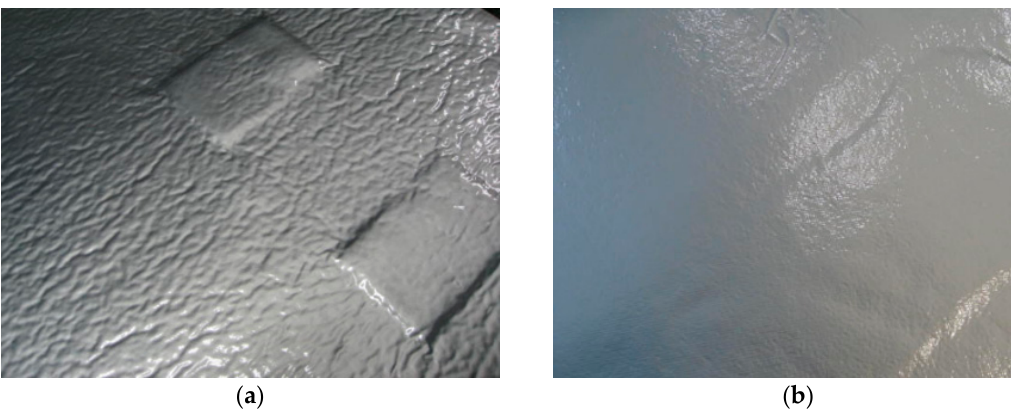
Figure 8. Comparison of formability improvement: ( a ) Conventional; ( b ) Improved.